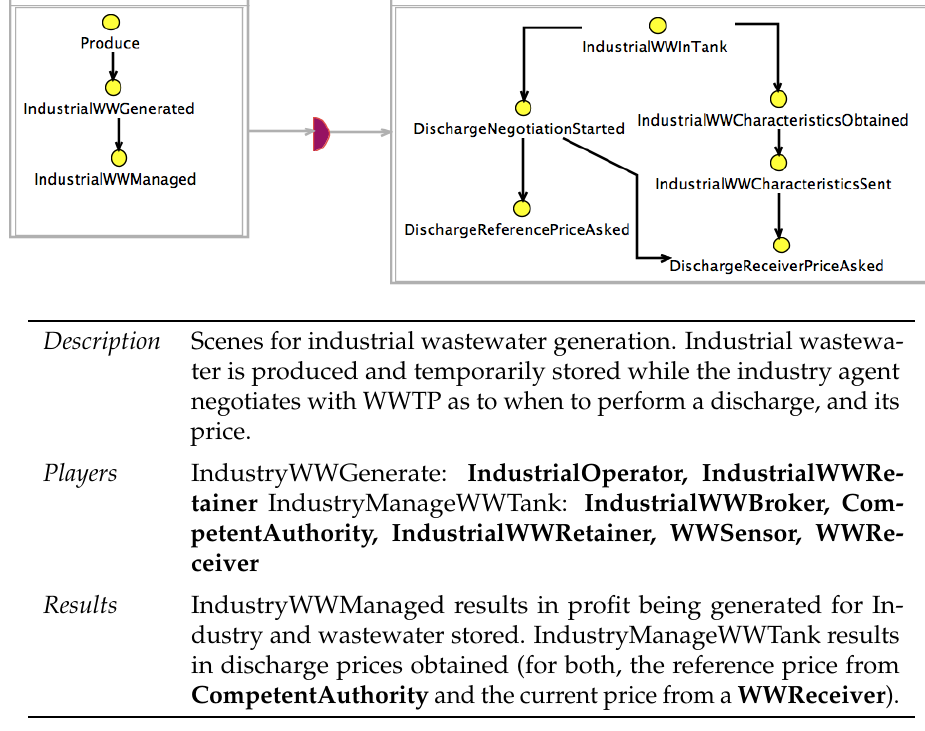
Figure 4. Composite of scenes for industrial wastewater generation and (partial) management. See the landmark patterns for other processes in Appendix